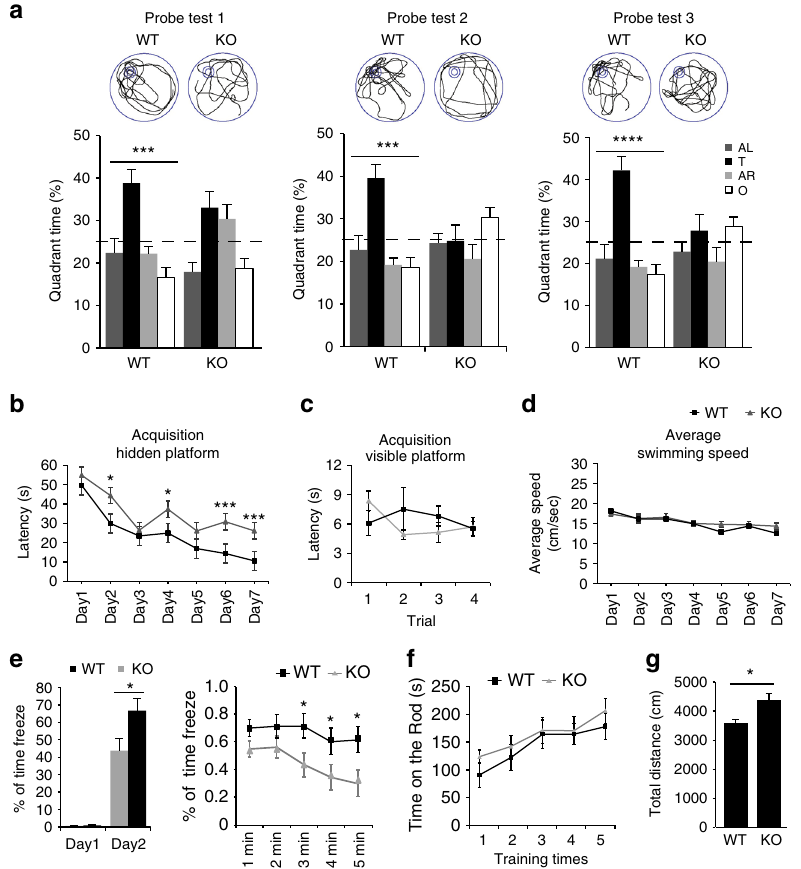
Fig. 1 Phf8 null mice show impaired learning and memory. a Morris water maze. Percentage time spent in each quadrant during the probe trials and representative swim trajectory of each group were given after 3 (probe test 1), 5 (probe test 2), and 7 (probe test 3) days of training (wild type (WT), n = 17; KO, n = 11; paired two-tailed t -test for water maze test). Four quadrants: adjacent left (AL), target quadrant (T), adjacent right (AR), opposite quadrant (O). b The escape latency time to reach the hidden platform during the 7-day training (WT, n = 17; KO, n = 11; unpaired two-tailed t -test). c The escape latency time to reach the visible platform within four trials given after probe test 3. d Average swimming speed of animals during the training with hidden platform. e Contextual fear conditioning test. Left, the baseline freezing time (Day 1) was recorded before foot shocks exposure to mice. The percentage of freezing time in the training context was measured 24 h after the conditioning (Day 2). Right, the freezing behavior of every minute observed during testing phase of contextual fear conditioning. The percentage of freezing time displayed signi fi cant difference in the last 3 min (WT, n = 15; KO, n = 12; unpaired two-tailed t -test). f Motor performance on the rota-rod. Both WT and Phf8 KO mice were given 5 trials on an accelerating rota-rod (4 – 40 r.p.m. over 5 min) within 1 day. The average duration time that mice stay on rota-rod in each trail was shown. (WT, n = 10; KO, n = 10). g Open- fi eld test. The total moving distance traveled in 20 min. (WT, n = 20; KO, n = 19; unpaired two-tailed t -test,). All data are represented as mean ± s.e.m. * p < 0.05, *** p < 0.001 and **** p <